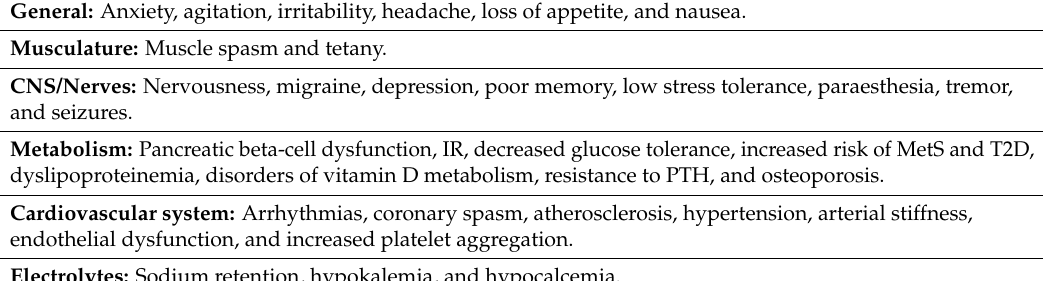
Table 1. Clinical manifestations of